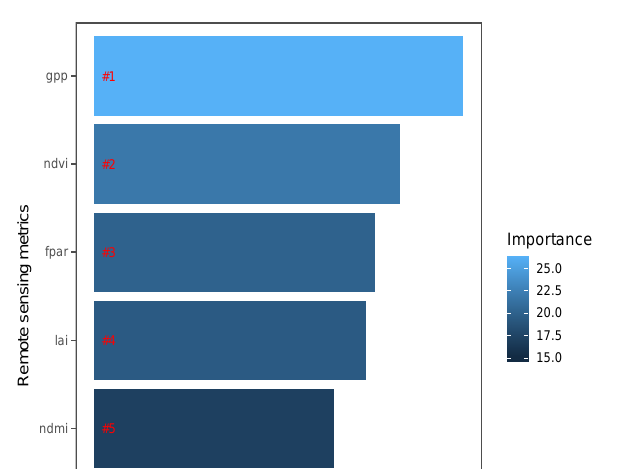
Figure 4. Remote sensing processing steps in GEE.